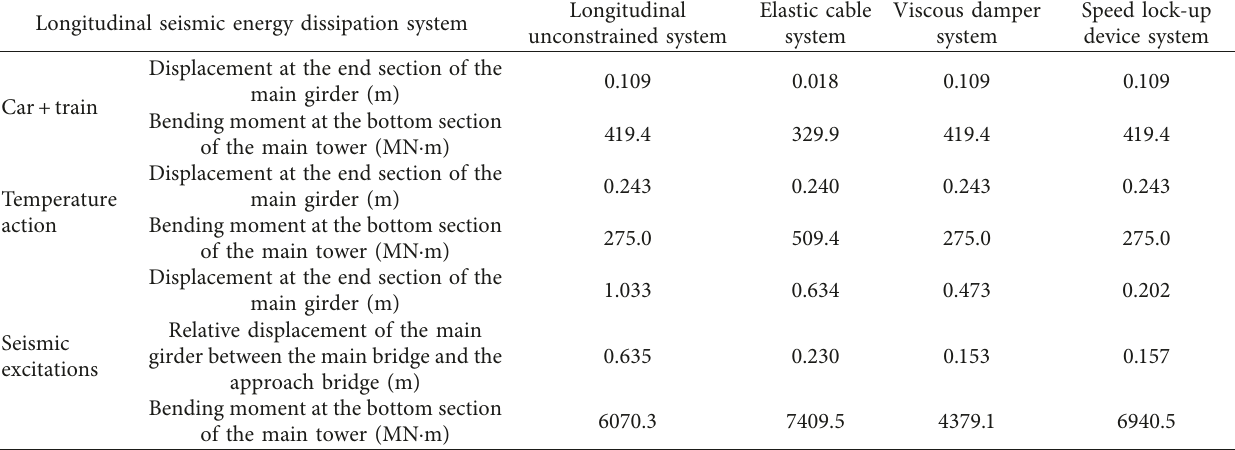
Table 5: Structural response of the four longitudinal seismic energy dissipation